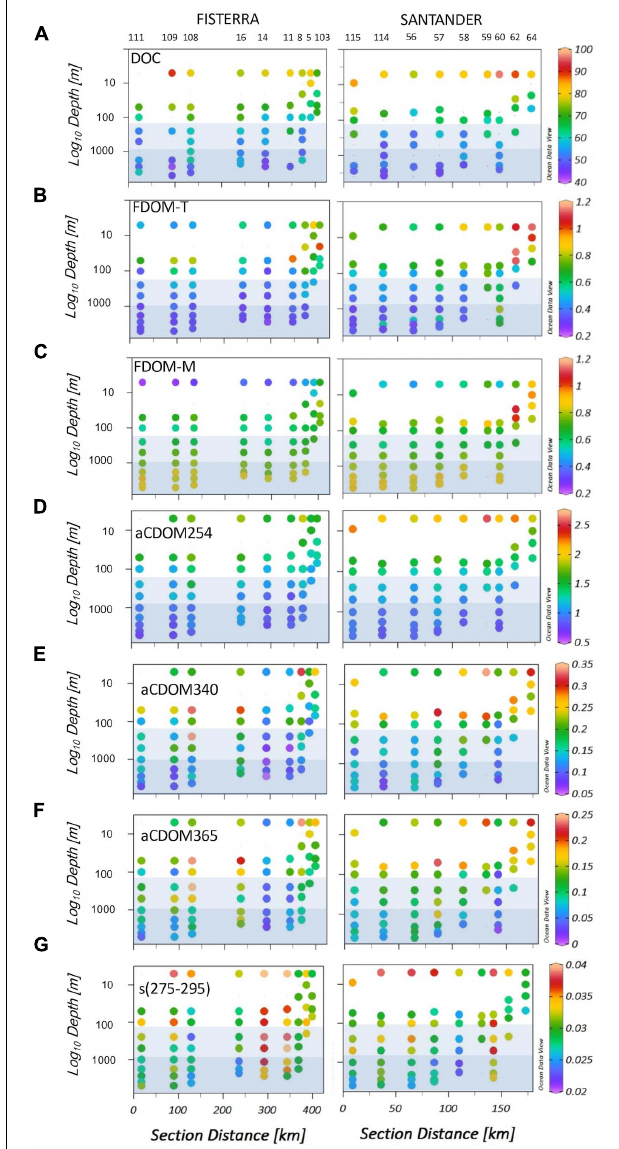
FIGURE 2 | Spatial distribution of DOM variables along Fisterra (left) and Santander (right) sections, in the NW Iberian upwelling system and adjacent open-ocean: (A) Dissolved organic carbon concentration (DOC, µ mol C L − 1 ), (B) FDOM-T (QSU), fluorescence of labile protein-like DOM, (C) FDOM-M (QSU), fluorescence of humic-like compounds, (D) aCDOM254 (m − 1 ), the absorbance of DOM at 254 nm; (E) aCDOM340 (m − 1 ), the absorbance of DOM at 340 nm; (F) aCDOM365 (m − 1 ), the absorbance of DOM at 365 nm; and (G) s(275-295), the 275-295 nm spectral slope. Light and dark blue squares indicate respectively meso- (201-1000 m) and bathypelagic (>1000 m) realms. Numbers overhead denote the sampling